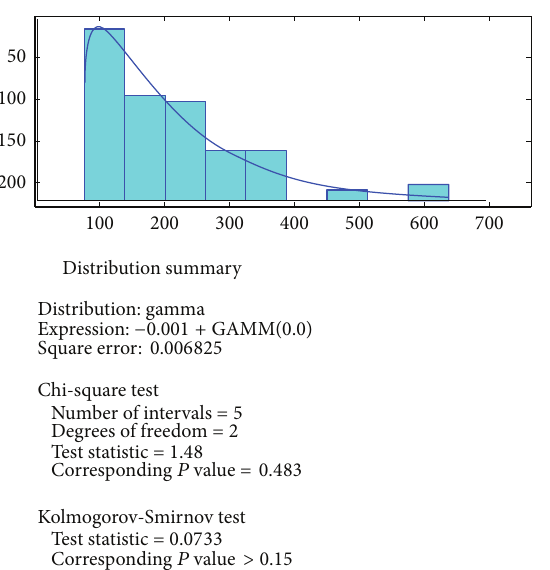
Figure 3: Distribution function of customer demand for reorder interval of product 𝐵 .